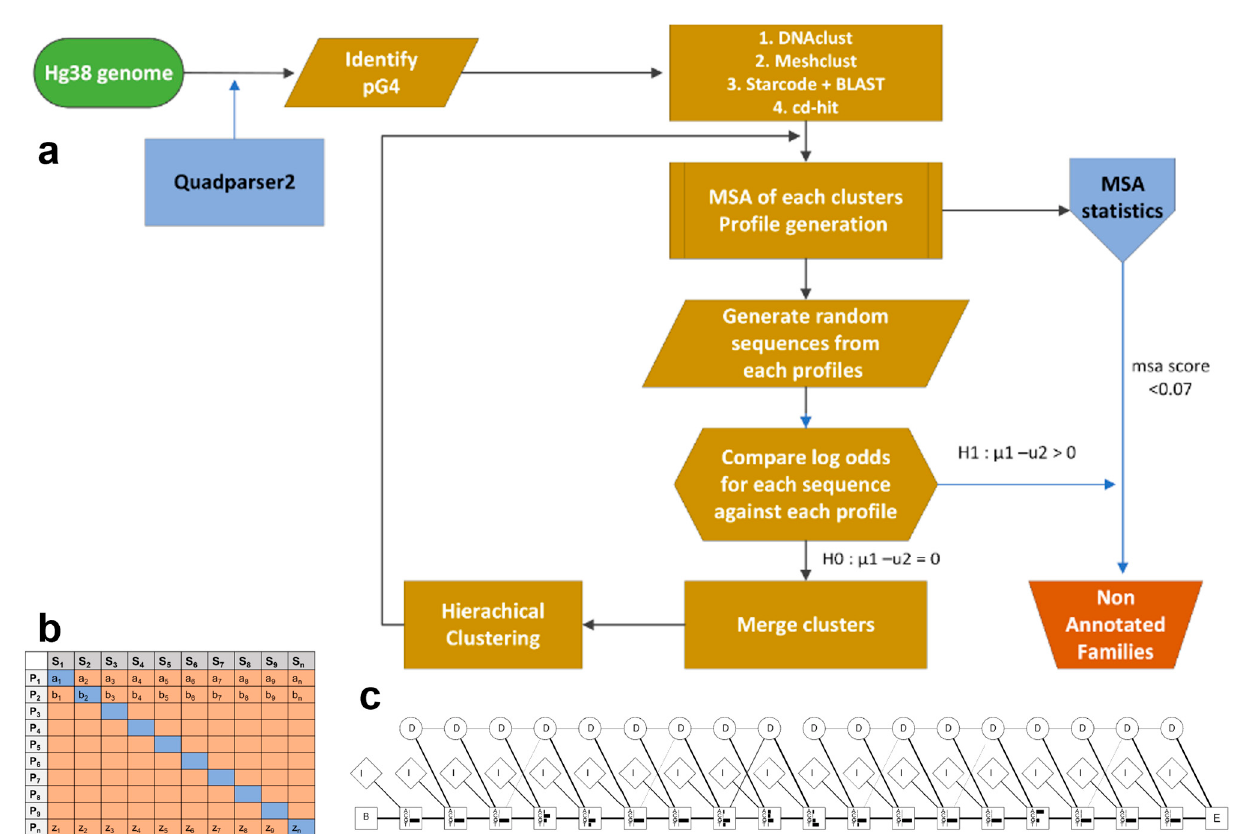
Figure 2. Process for identifying and characterizing G-quadruplex families. ( a ) Workflow diagram for identifying distinct G-quadruplex families. ( b ) Process for identifying appropriate profiles for a specific family. In this case, S 1 , …, and S n represent the list of sequences generated from HMM profile P 1 , …, and P n , respectively. We compare the average log odds for input S 1 over profile P 1 …P n and recursively measure for all the profiles. For each row, the diagonal element is compared with non-diagonal values (log odds) using a Wilcoxon rank sum test with a null and alternate hypothesis, H 0 : T 1 –T 2 = 0, H 1 : T 1 –T 2 > 0. ( c ) Profile HMM derived from a selected G4 alignment. Match states are represented as rectangles with four residue emission probabilities indicated as black bars, insert states (I) as diamonds, and delete states as circles. The start and end states are B (begin) and E (end), respectively. Delete states are silent states with no emission probabilities and weighed lines represent the transition probabilities between states.